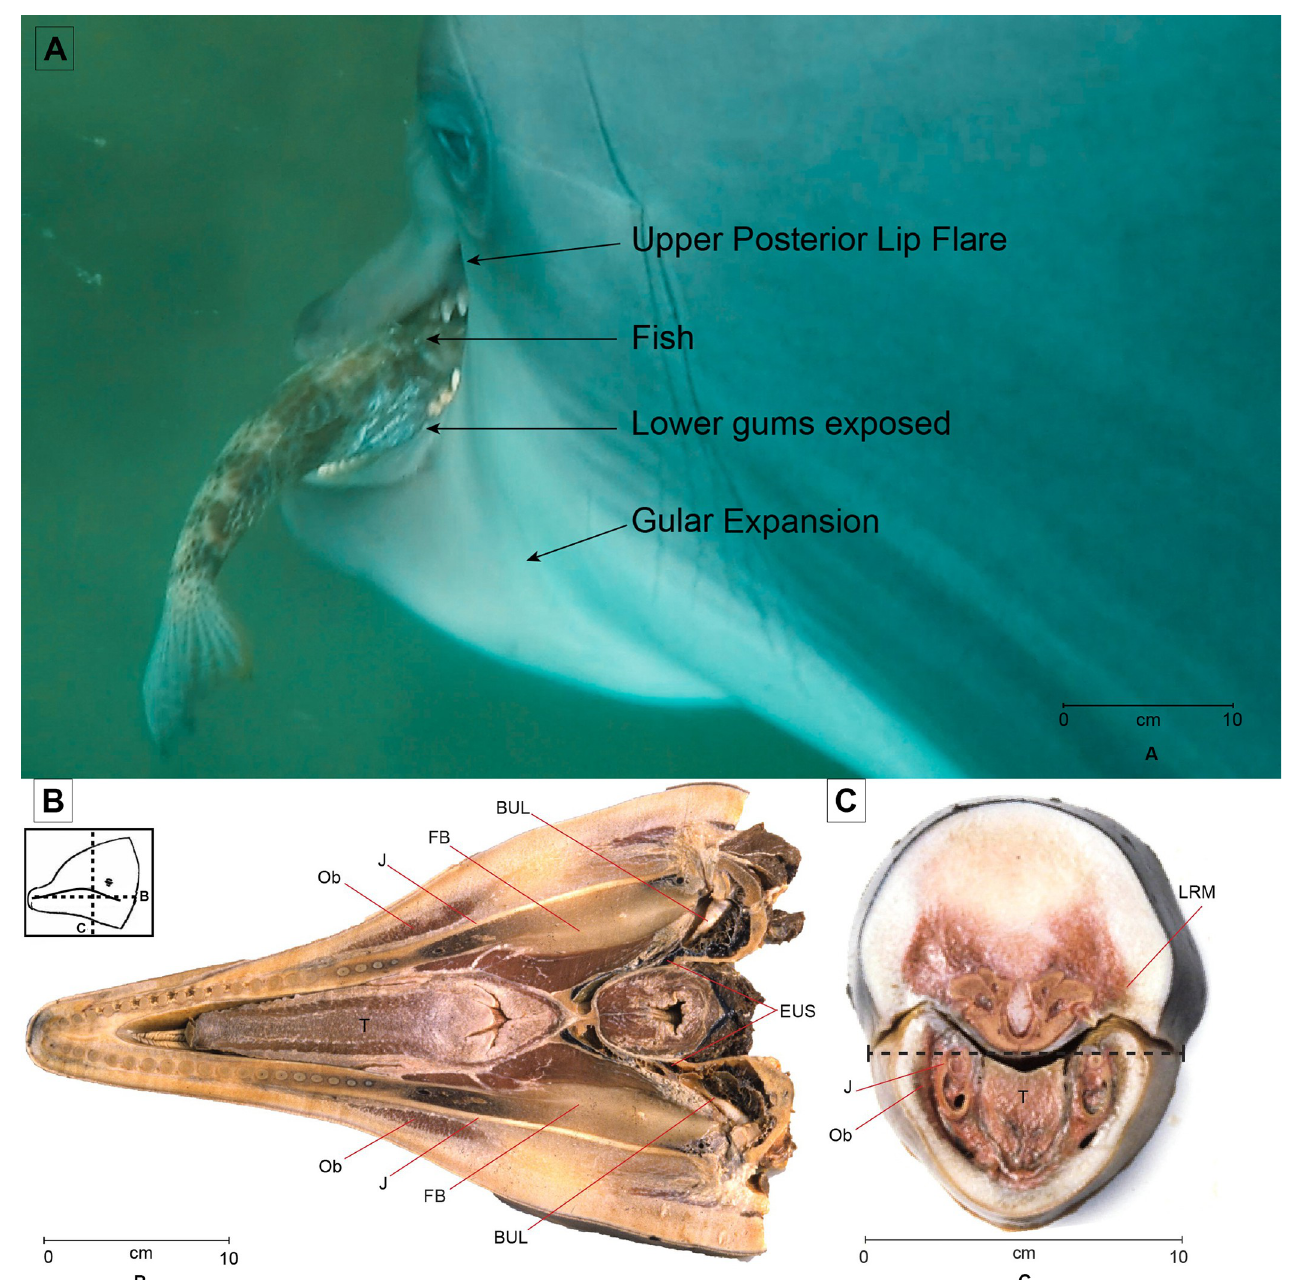
Fig 8. Dolphin fish capture with anatomy showing relationships of some muscles of the upper and lower lip. A. view of Dolphin K as a fish is prepared for swallowing. Lips are opened by muscles Ob below and LRM above, tongue (T) is withdrawn and gular muscles facilitate expansion that sucks the fish down. The box shows the orientations of B . and C. horizontal section through lower jaw. Ob orbicularis oris, muscles of lower lip, J Jaw, FB, fat body of jaw, BUL auditory bulla or tympanic bone, EUS Eustachean tube. B. Frontal section through the mouth just anterior to the lip commissure. Dashed line in C. shows the approximate orientation of B. Ob orbicularis oris muscles of lower lip, LRM lateral rostral muscle. J, jaw bone, T, tongue.